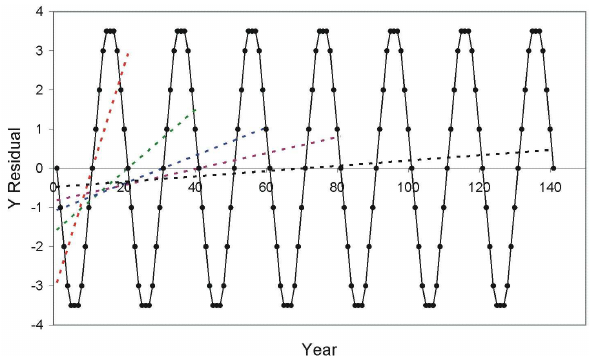
Figure 3. Artificial hysteresis of y in terms of x during a single cycle (solid line) and the “ideal” linear function of y in terms of x during the same cycle (dashed line).